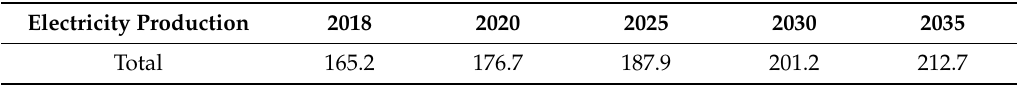
Table 5. Forecasted electricity production